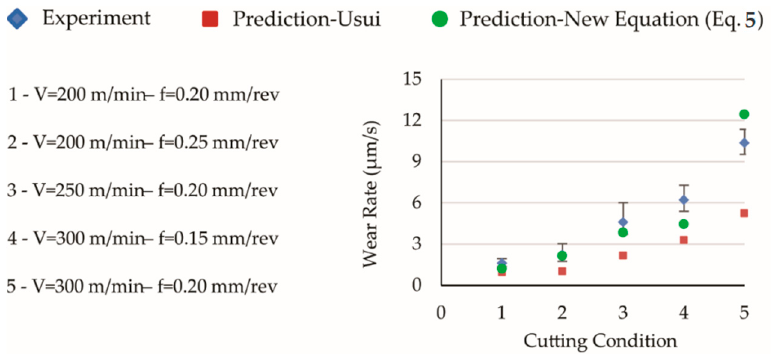
Figure 13. Predictions of wear rate in the initial period of cutting based on original Usui and new equations.